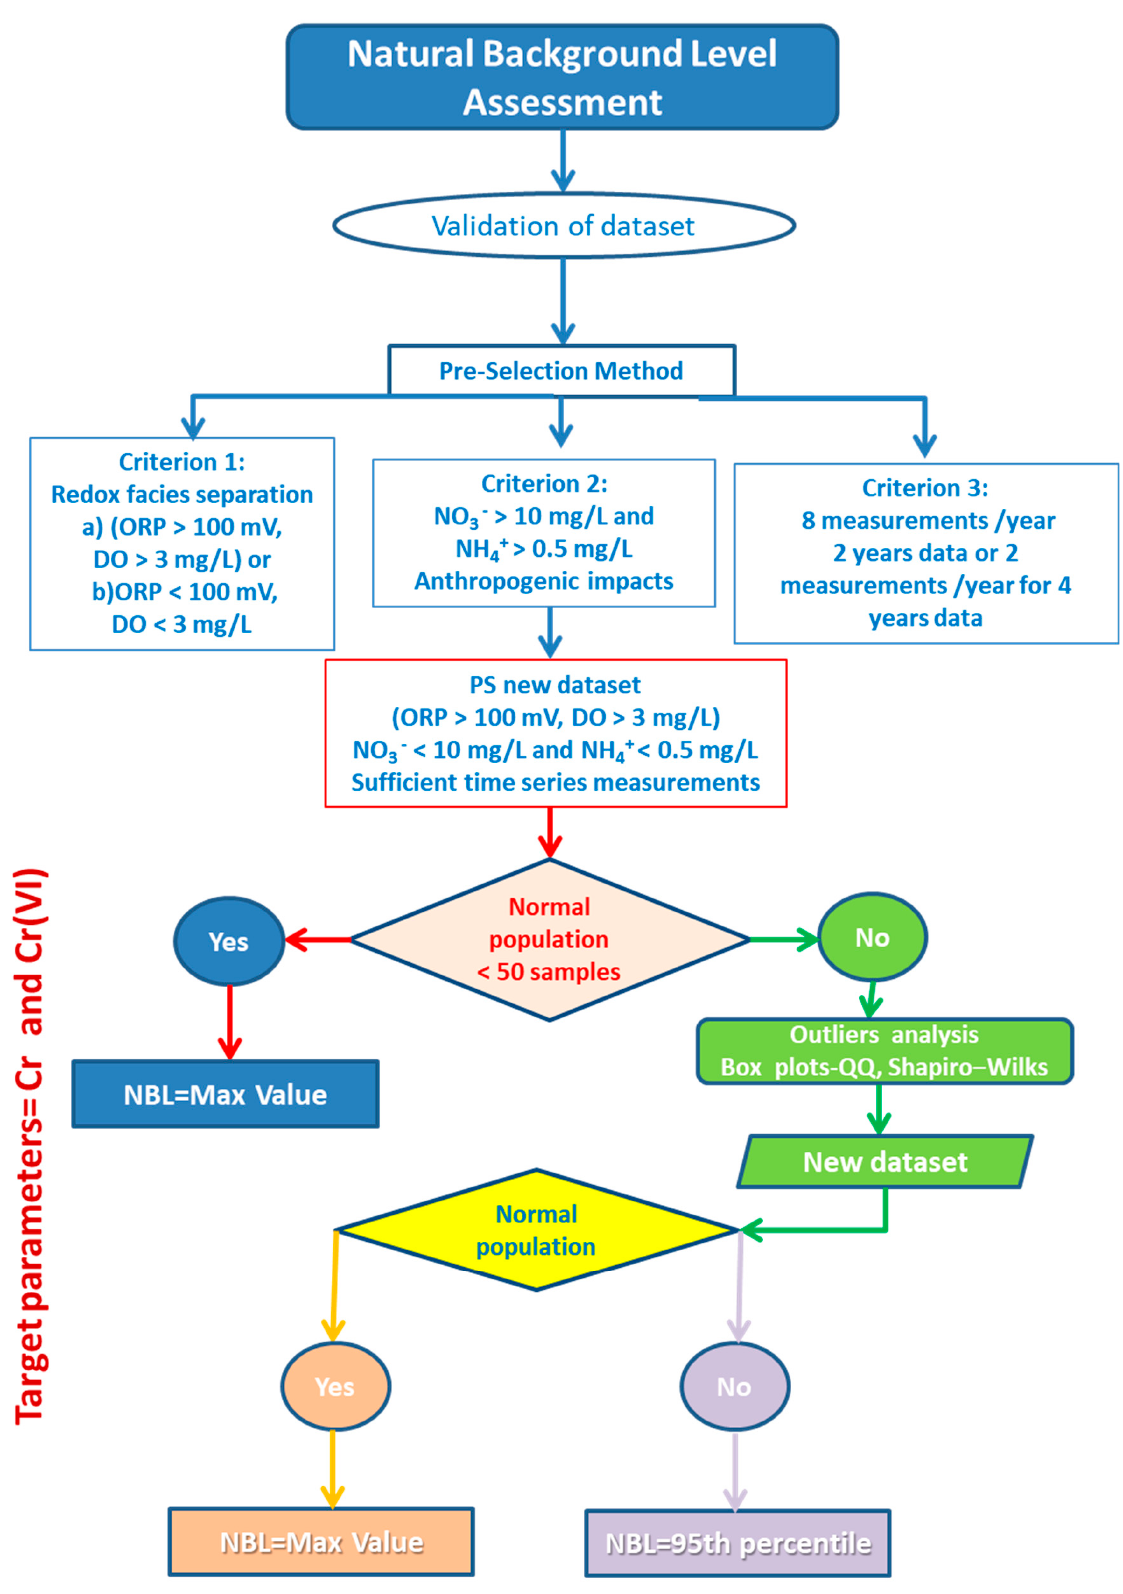
Figure 4. Flow chart of the modified conceptual model for the assessment NBLs of the target parameter.